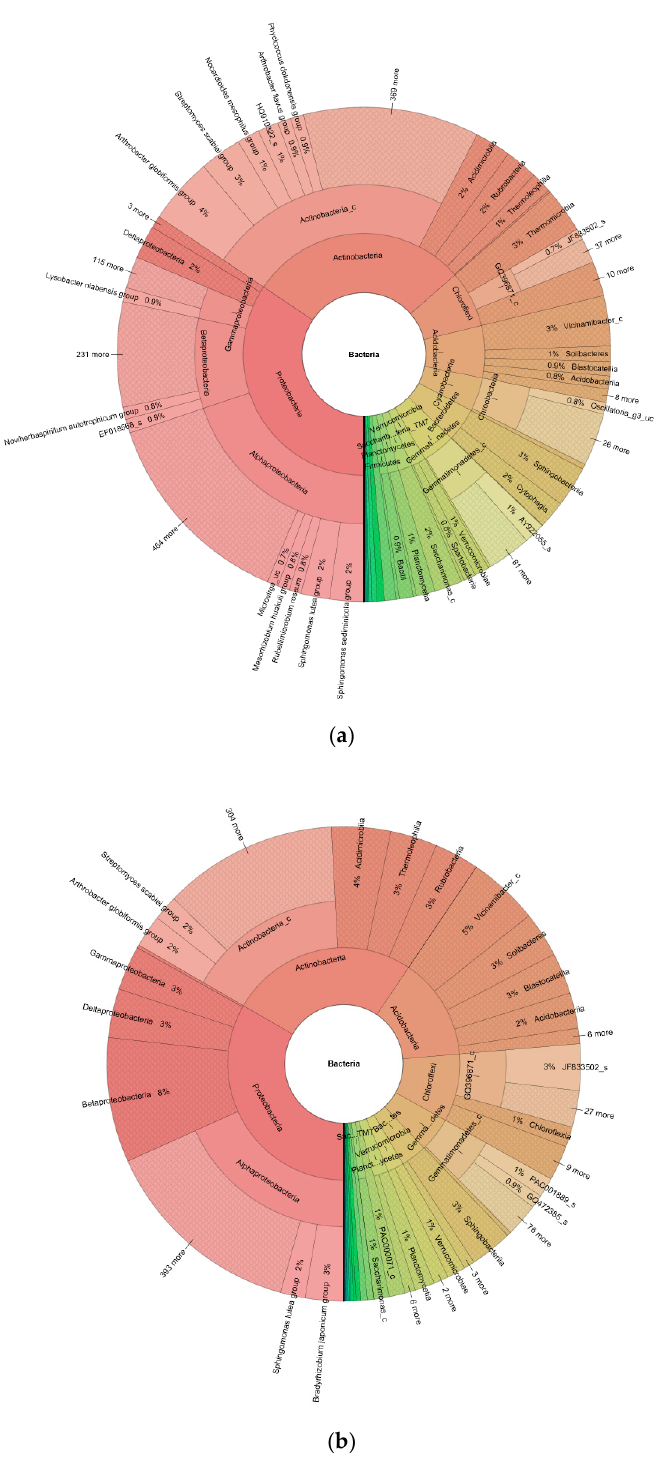
Figure 7. The 16s rRNA sequencing results of soil bacteria community in ( a ) control soil ( b ) field soil (contaminated).